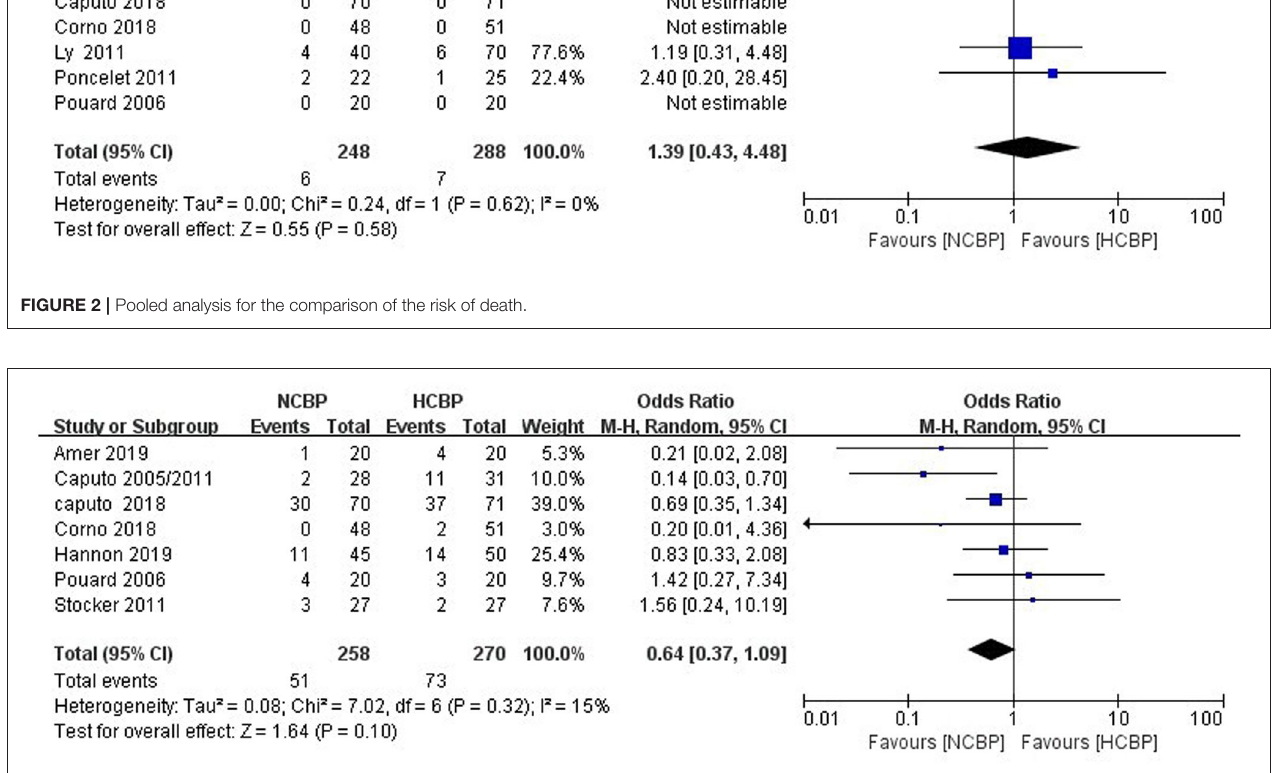
FIGURE 3 | Pooled analysis for the total adverse